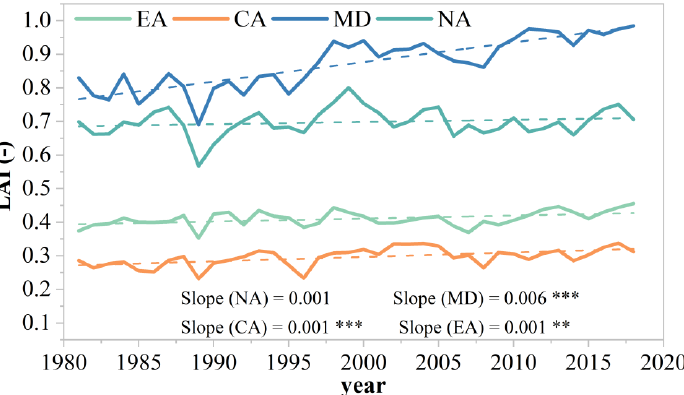
Figure 7. Temporal variation trends of LAI in four regions from 1981 to 2018 (**, p < 0.01; ***, p < 0.001). Given that the spatial distribution of vegetation variation trends was not uniform, the spatial variation trends of the annual average vegetation LAI in the four regions were analyzed (Figure 8).